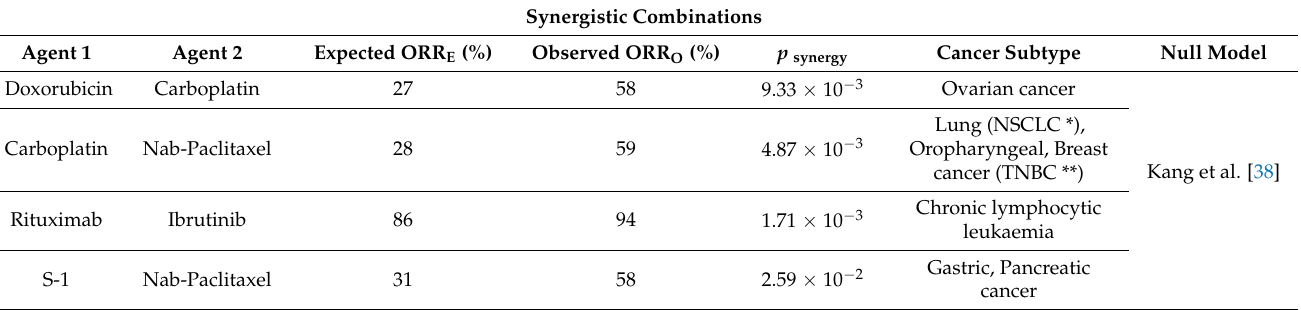
Table 2. List of inferred synergistic combinations.